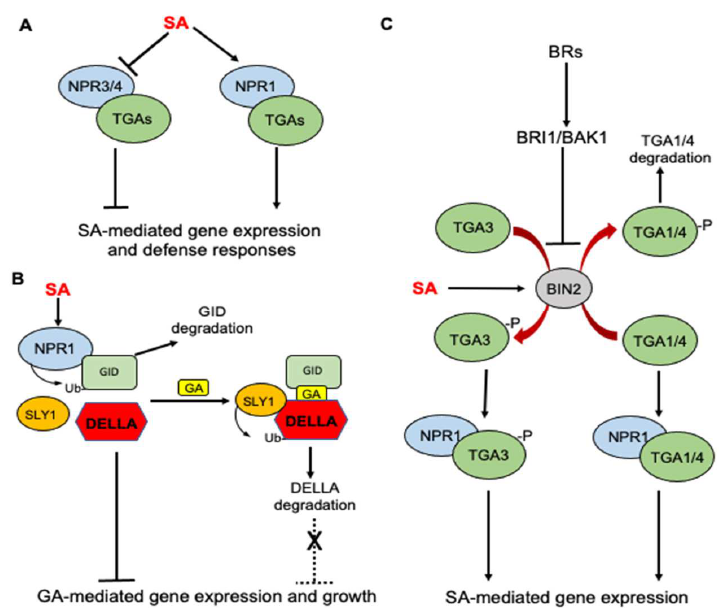
Figure 1. Roles of NPR receptors in SA-regulated defense responses and SA crosstalk with GA and BR in Arabidopsis. ( A ) SA binding activates NPR1, which acts as transcription coactivator of TGA transcription factors for SA-mediated gene expression. NPR3 and 4 are transcription repressors but SA can inhibit their repressor activity to release the repression of SA-mediated defense genes. ( B ) SA receptor NPR1 interacts with the GA receptor GID1 to promote its degradation, thereby enhancing the stability of GA repressor DELLA to inhibit GA signaling and plant growth. ( C ) SA activates BIN2 kinase, a negative regulator of BR signaling. Activated BIN2 kinase phosphorylates TGA3 transcription factor and enhances its DNA-binding activity but phosphorylates TGA1/4 transcription factors to inhibit their interaction with NPR1 and decreases their